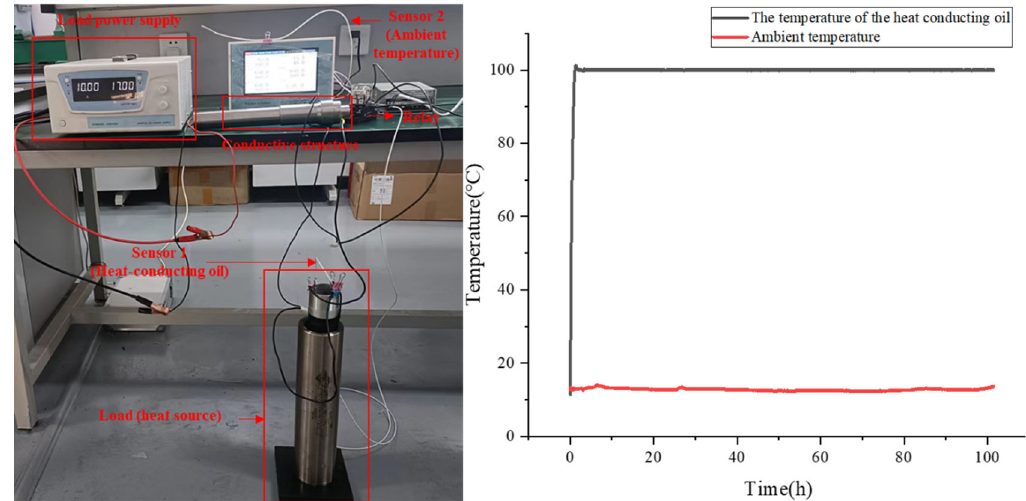
Figure 28. Long-term experiment and results of the stability of the energy supply by the conducting central rod.